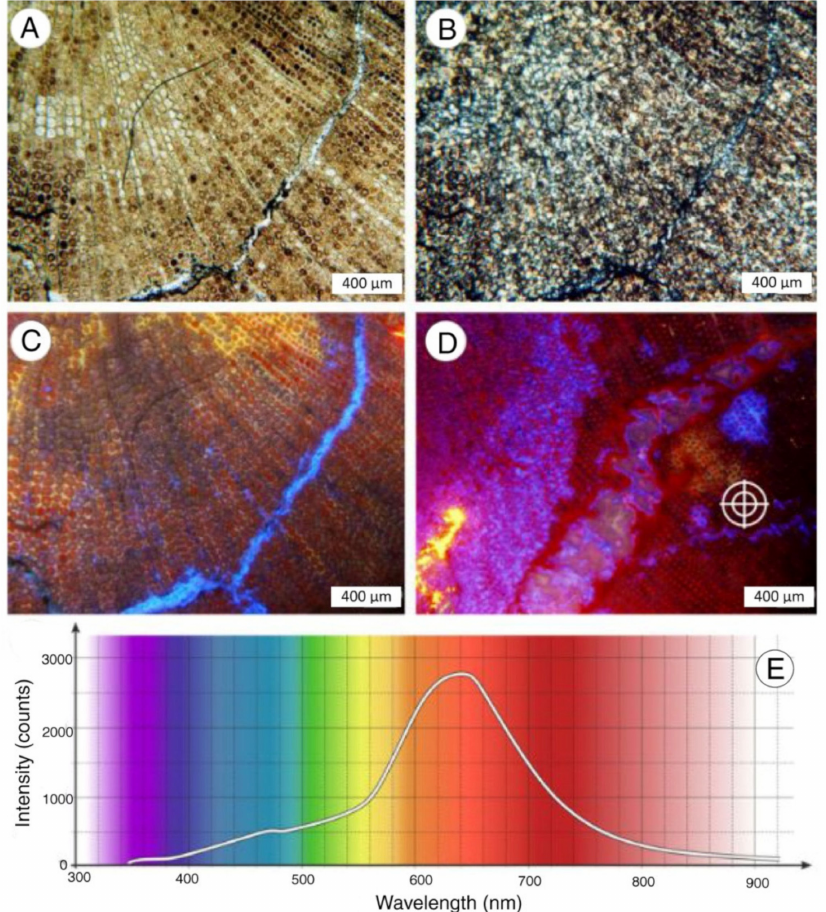
Figure 16. CL data from silicified wood from the Carboniferous Flöha Formation, near Falkenau, East Central Germany. This specimen is from anatomically well-preserved wood of the inner part of the root. ( A ) Transmitted light view. ( B ) Polarized light view. ( C ) CL image. Note limitation of yellow CL to the former cell walls, whereas red CL occurs within the cells. Fracture filling shows a short-lived blue CL. ( D ) All CL spectra detected from the inner root in this specimen. ( E ) Spectrum taken at marked area in ( D ) detected from the sample; image taken from the inner root. Note that anatomical preservation. Figure is modified from